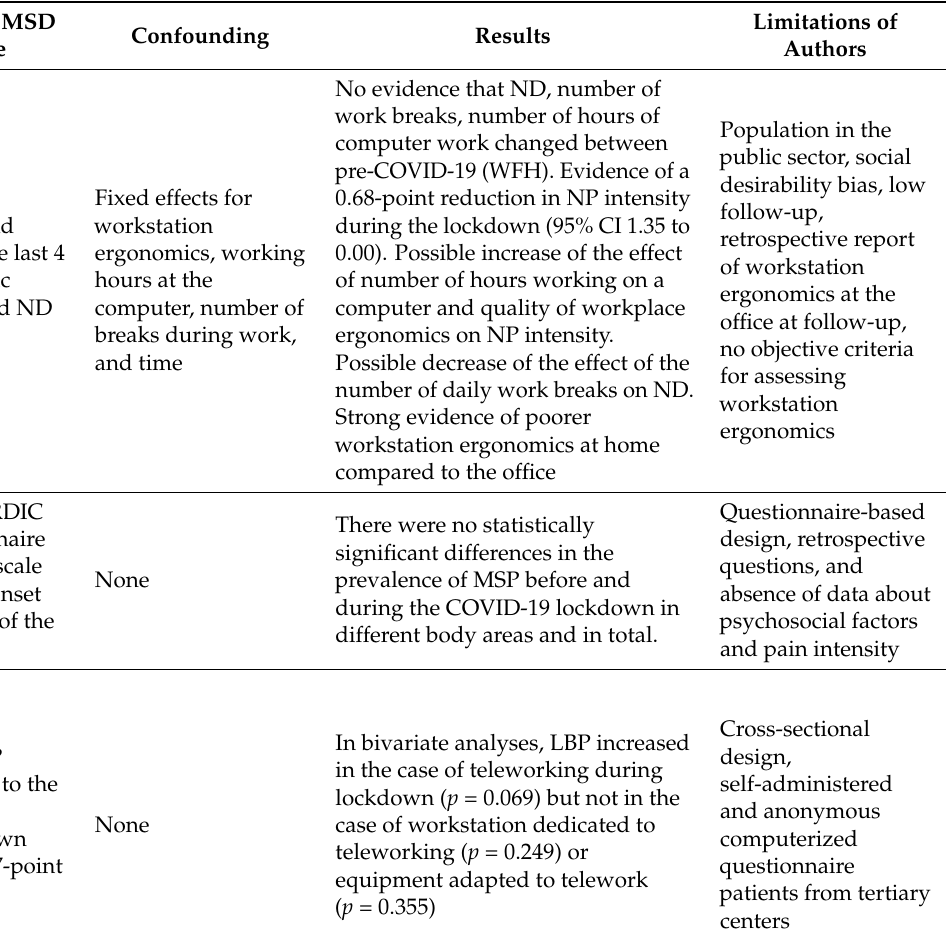
Table 1. Summary of data extracted from selected